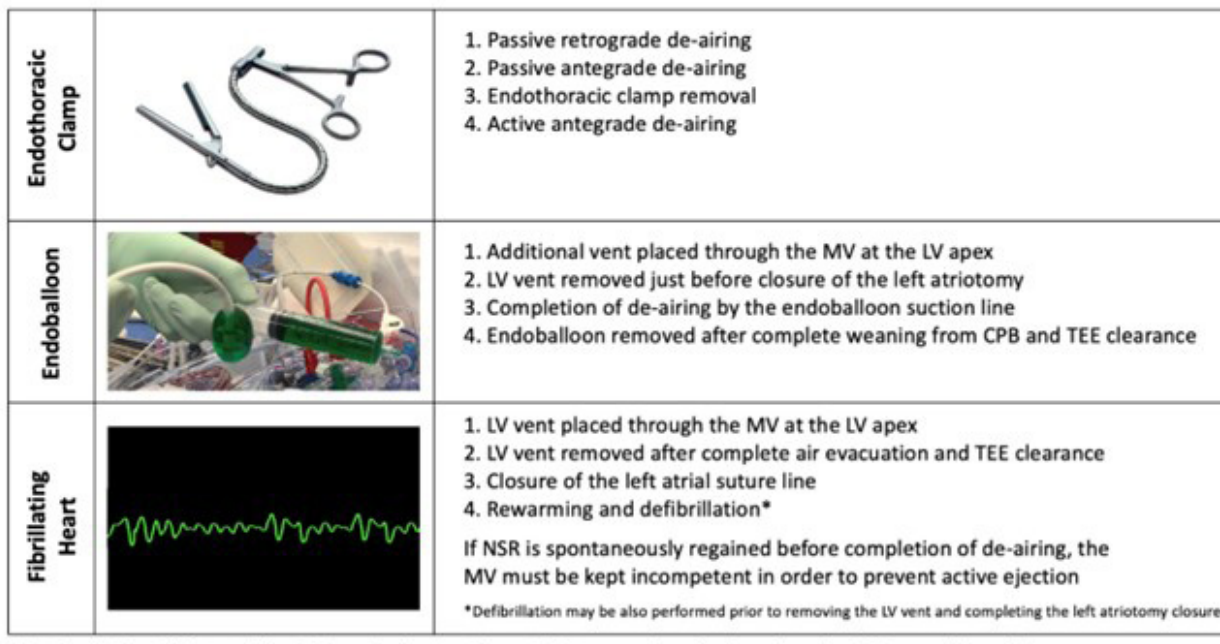
Fig. 2 - De-airing steps according to different cannulation strategies. CPB=cardiopulmonary bypass; LV=left ventricular; MV=mitral valve; NSR=normal sinus rhythm; TEE=transesophageal